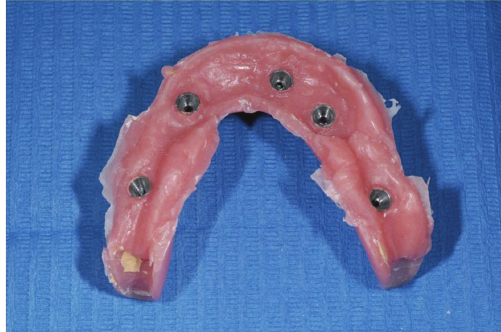
Figure 6: Titanium bar constructed by the dental technician.